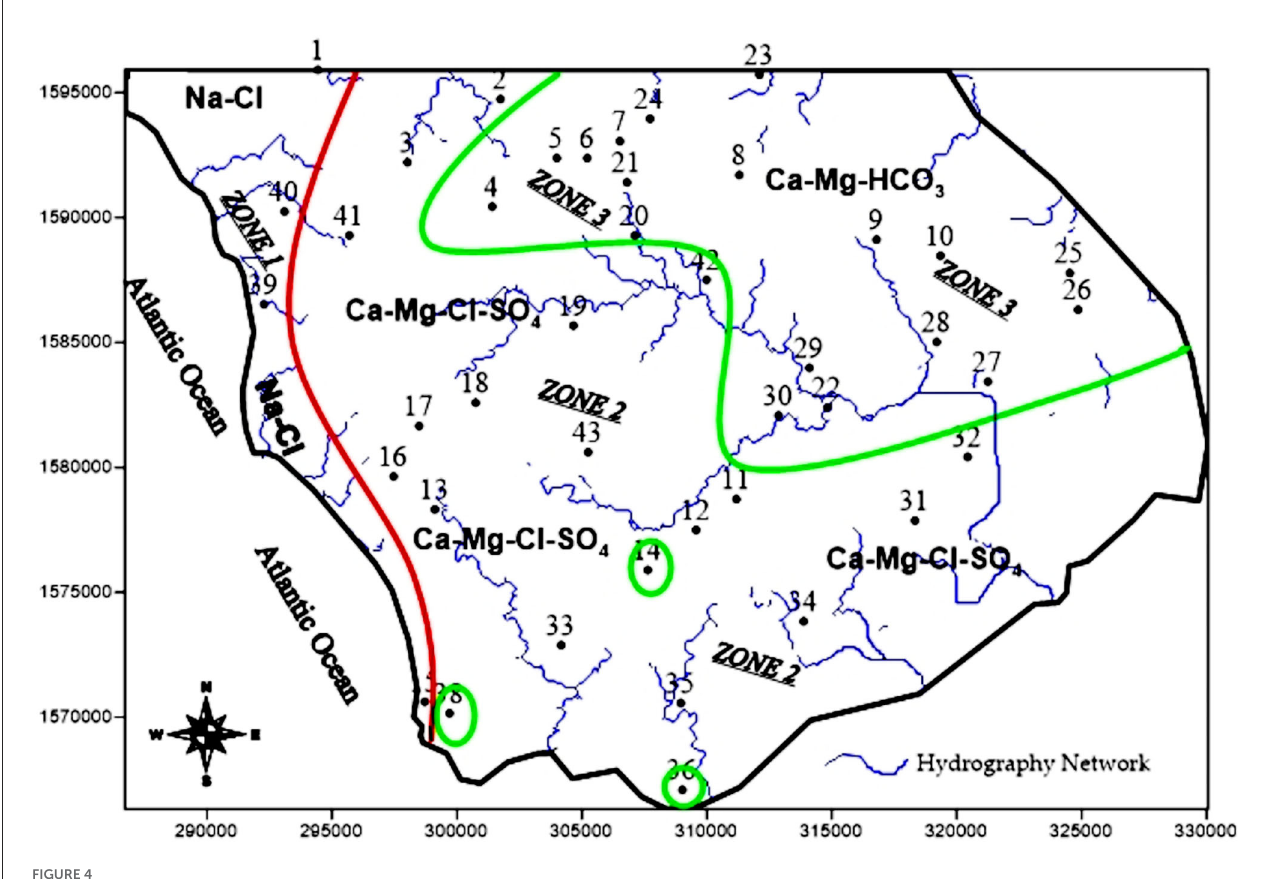
FIGURE4 Spatial distribution of the water faces